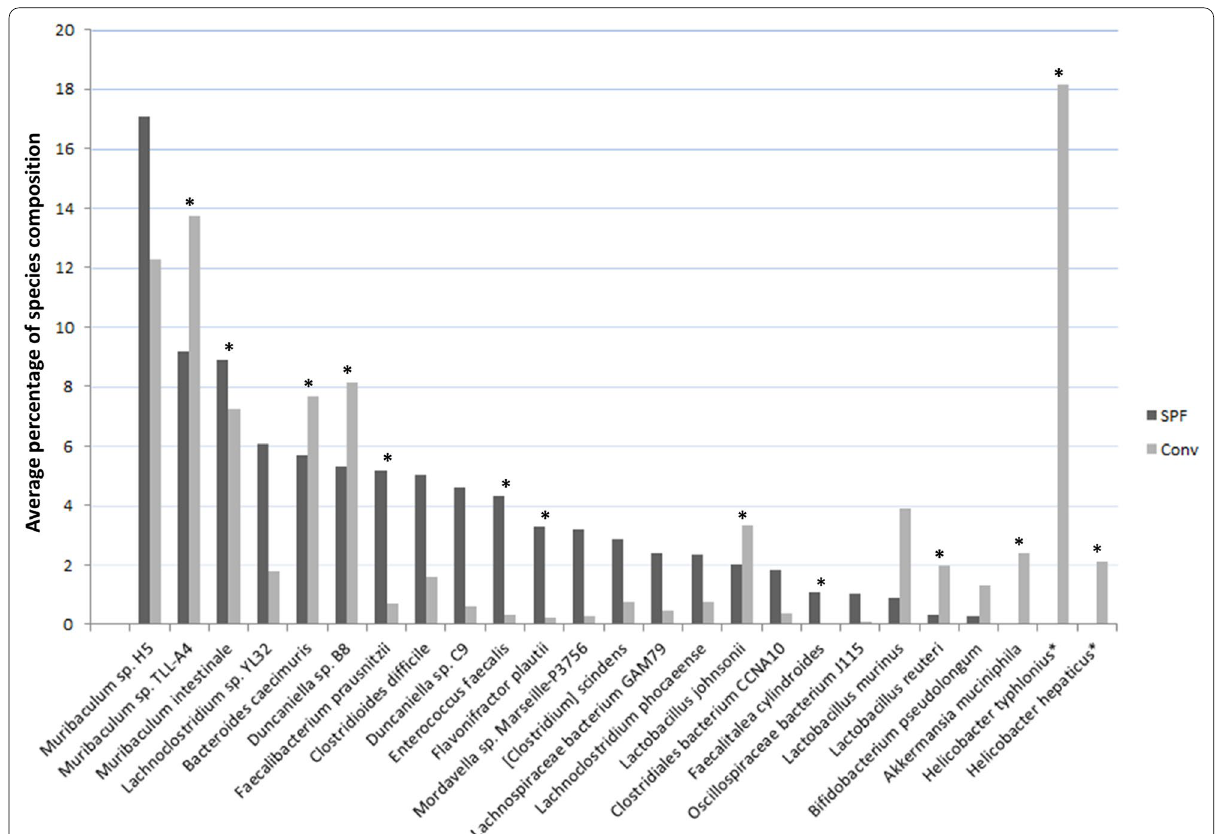
Fig. 4 Comparison between abundant microorganisms in the SPF and non-SPF samples. Graph represents 18 species commonly shared between the two groups and 5 additional species ( Faecalitalea cylindroides , Bifidobacterium pseudolongum, Akkermansia muciniphila, Lactobacillus murinus, and Lactobacillus reuteri ) present at a very low fraction in one of the two groups. In addition, Helicobacter typhlonius and Helicobacter hepaticus constitute approximately 20% of the microorganisms in the non-SPF mice, while they are absent in the SPF mice. Asterisk (*) indicates species with a statistically significant differential abundance ( p value <